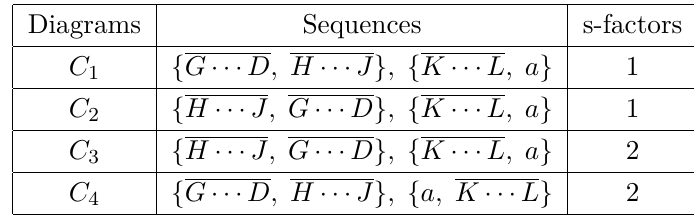
(1 , 1 , k + p, m + l, q + n ) 5